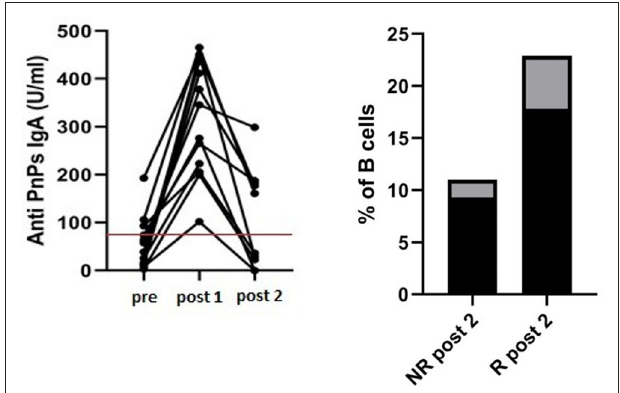
FIGURE 7 | Long-term IgA antibody response in 16 CVID responders. Anti-PnPs IgA antibody in CVID before vaccination (pre), 4 weeks after vaccination (post 1) and after 36 ± 6 months (post 2) Red line indicates the cut off (80 U/ml) (left panel). Patients with a long-lasting IgA response at post 2 had a higher frequency of switched memory B cells in comparison to patients losing IgA response at post 1 ( p < 0.02) (right panel). Black columns refer to mean value and gray columns refer to SD